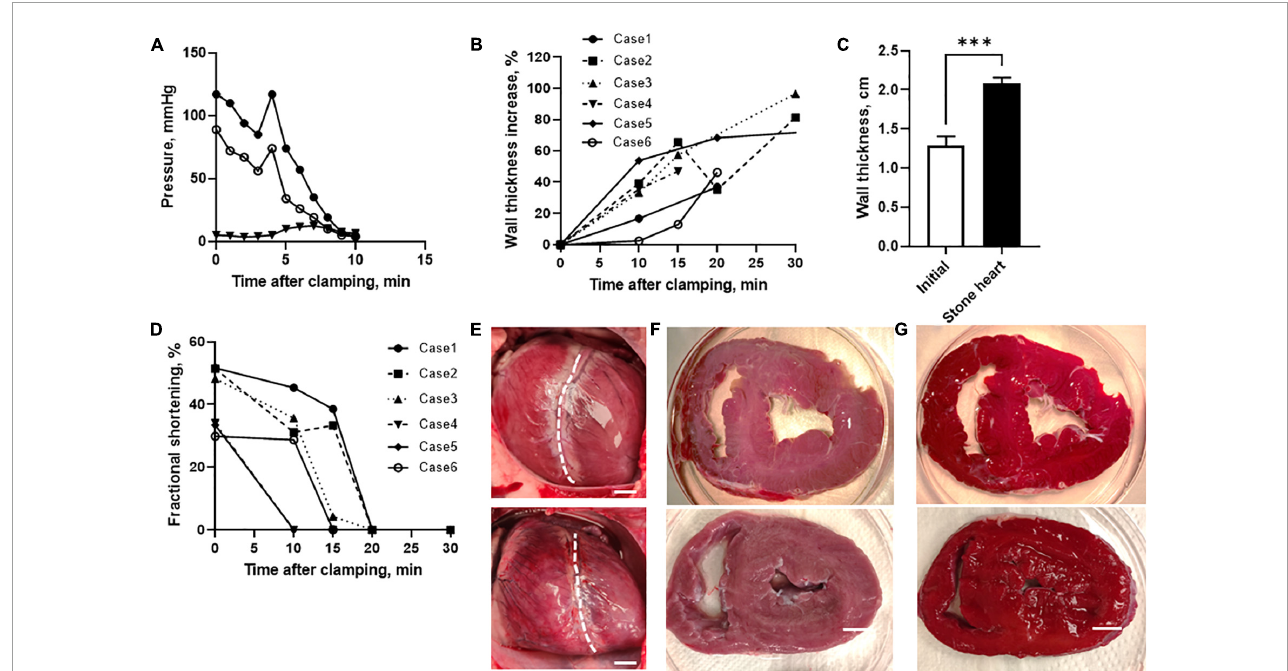
FIGURE1 Development of stone heart in a pig model. (A) Systolic (filled circles), diastolic (open circles), and mean venous (triangles) pressure of a pig after induction of asphyxia. (B) Left ventricular wall thickness (diastolic) relative to initial at different time after trachea clamping, determined using ultrasound in individual animals (case 1–6). Note, case 5 reached stone heart at 60 min after asphyxia. (C) Mean left ventricular wall thickness before asphyxia and in the stone heart condition ( n = 6 in animals each group). (D) Fractional shortening determined at different time points using ultrasound. (E) Photos of hearts prior to asphyxia (upper) and after development of ischemic contracture (stone heart condition, lower), dashed line indicates the border between left and right ventricles, with left ventricle is oriented to the right. Note, the enlarged right ventricle (due to pooling of blood) and the contracted left ventricle in the stone heart condition representative photos in the series of six animals. (F) Slices through the mid-section of a normal heart (upper) and a stone heart (lower). (G) Corresponding TTC stained slices. Representative photos in the series of four animals in each group. Scale bars in (E–G) : 1 cm. ∗∗∗ p <